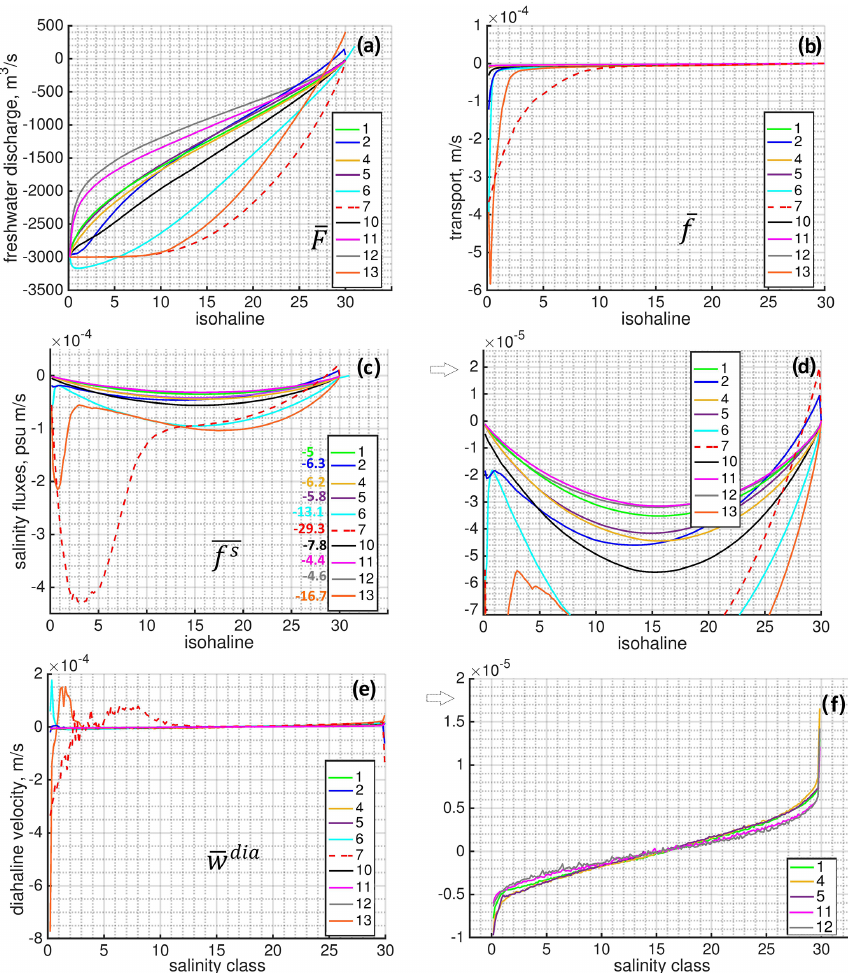
Figure 11. Analysis of numerical diffusion in the system: (a) total freshwater discharge through different isohalines, F (m 3 s − 1 ); (b) transport per unit area of each isohaline, f (ms − 1 ); (c, d) total salinity fluxes through different isohalines, f s (psums − 1 ). The numbers indicate the sum of the salinity fluxes multiplied by 10 3 . (e, f) Diahaline velocities, w dia . In all pictures the characteristics are averaged over the second inertial period. In panels (b) and (e) the curves of runs 1, 4, 5, 11, and 12 are relatively close to each other.